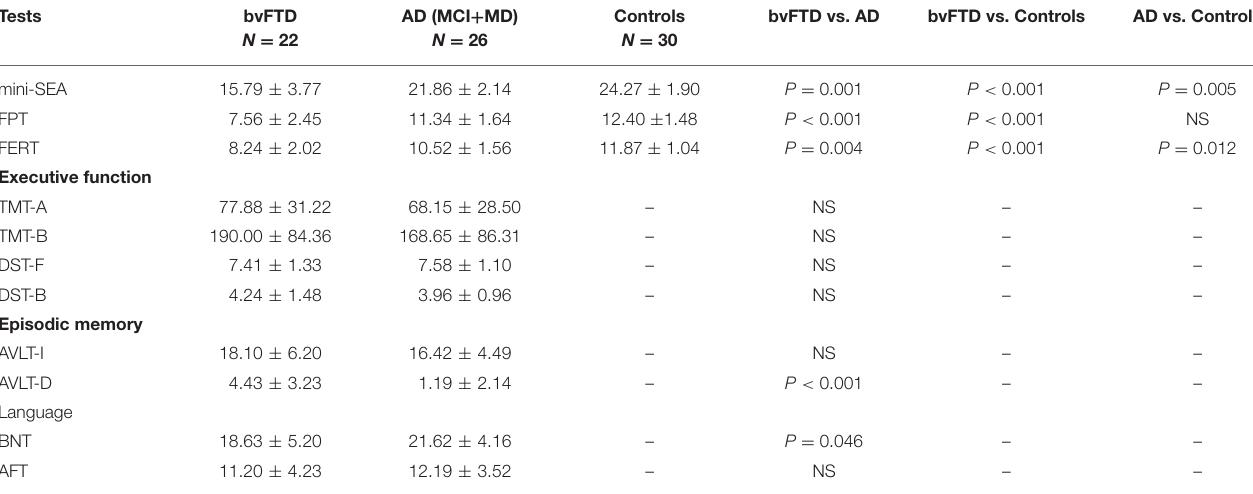
TABLE 2 | Performance of Mini-SEA and cognitive tests on executive function, episodic memory and language for the bvFTD, AD and control groups. Tests AD vs.